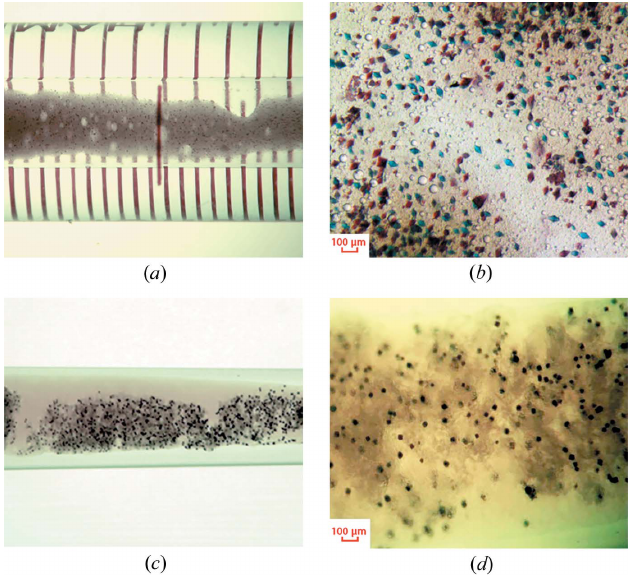
Figure 2 RC crystals obtained in LSP. ( a ) Inside a Hamilton gas-tight glass syringe; ( b ) a Hamilton gas-tight glass syringe under magnification; ( c ) inside a sealed plastic tip; ( d ) a sealed plastic tip under